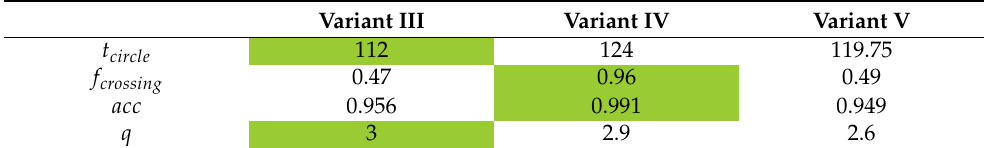
Table 7. Values of performance metrics obtained for three variants of (cid:101) χ updating; simulation scenario Cloud 4 .